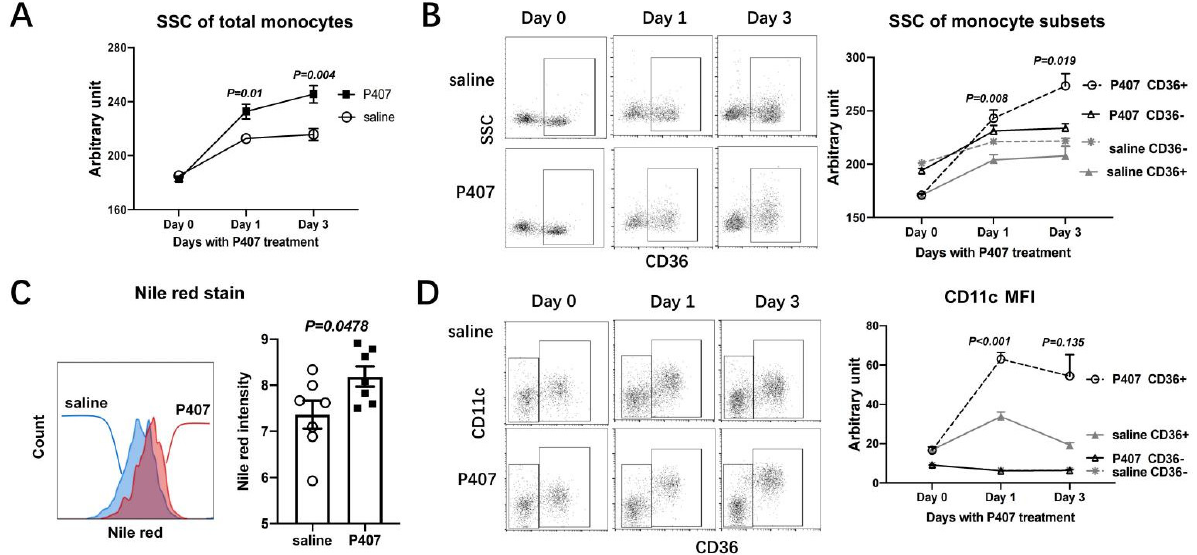
Figure 3. Increased lipid accumulation and CD11c levels in CD36 + monocytes of Ldlr –/– mice with P407 injection. Changes in side scatter (SSC), indicating lipid accumulation, of ( A ) circulating monocytes and ( B ) monocyte subsets defined by CD36 in Ldlr –/– mice prior to (day 0) and on days 1 and 3 of P407 or saline injection. ( C ) Nile red staining for lipids of circulating CD11c + (also CD36 + ) monocytes in Ldlr –/– mice on day 1 of P407 or saline injection. ( D ) Changes in CD11c levels indicated by mean fluorescent intensity (MFI) of monocyte subsets in Ldlr –/– mice prior to (day 0) and on days 1 and 3 of P407 or saline injection. n = 5–7 mice/group. Data are shown as mean ± SEM and were analyzed by two-way ANOVA with repeated measures and assumption of inequivalence of variance, followed by Šídák’s multiple pairwise comparisons test ( A , B , D ) or by the unpaired Student’s t -test ( C ). p -values indicate comparisons of ( A ) monocytes or ( B – D ) the same monocyte subsets between the P407 group and controls.